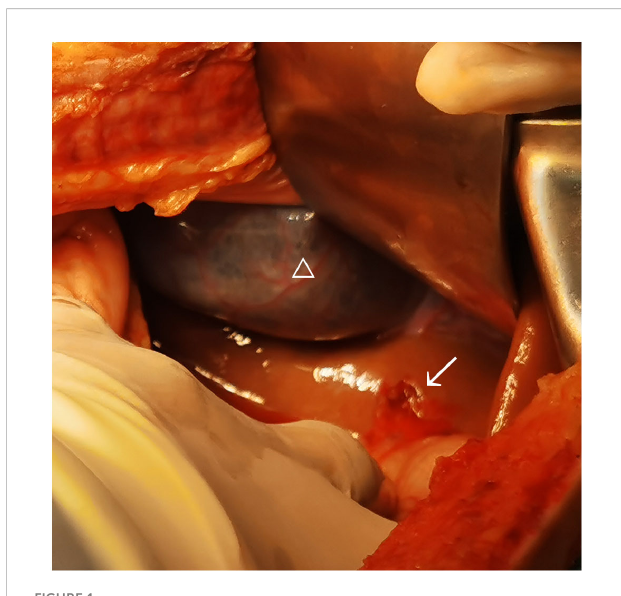
FIGURE 1 Hepatic rupture of case 1. “ △ ” represents gallbladder; “ ! ” represents hepatic rupture.